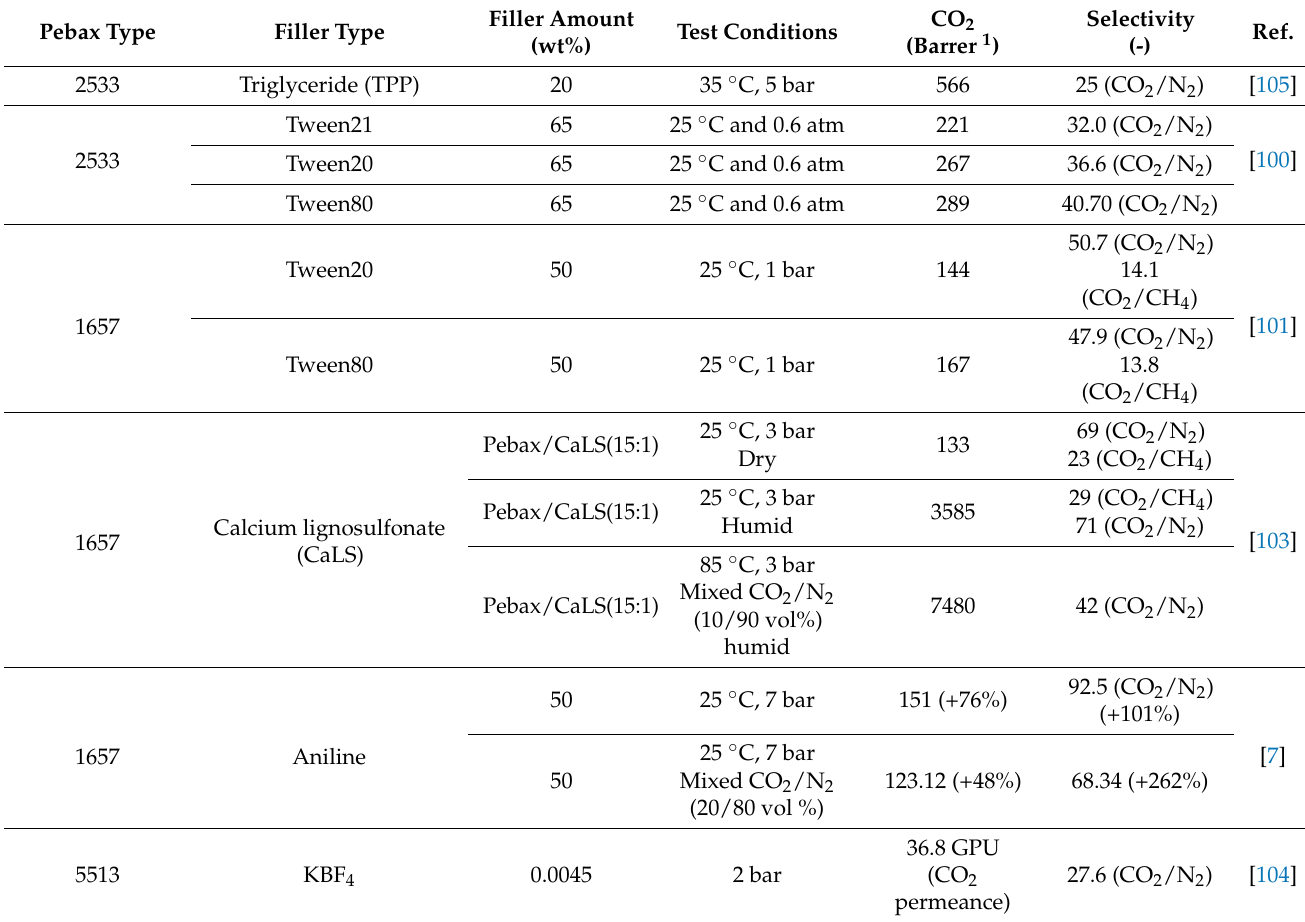
Table 11. Permeation properties of selected Pebax-based MMMs filled with ionic and non-ionic additives. Pebax